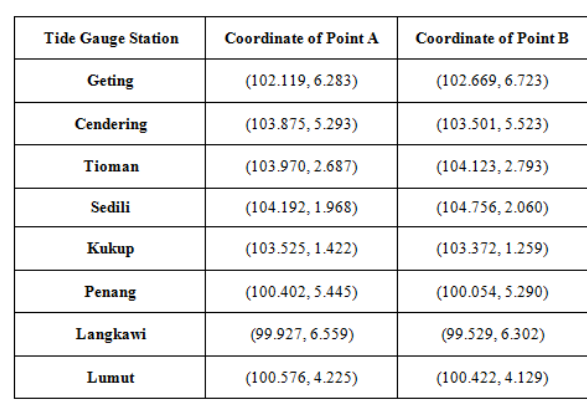
Figure 22. Slope of Lumut The Coordinate of all Point A an Point B are shown in Table 3.